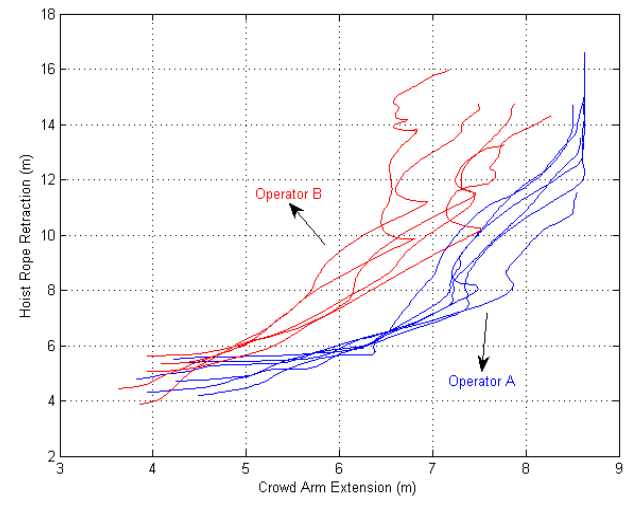
Figure 13. Digging trajectory for Operators A and B